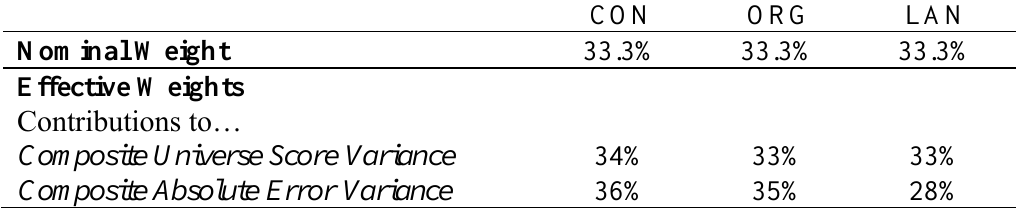
Table 10. Relative contributions of sub-scale to composite universe score